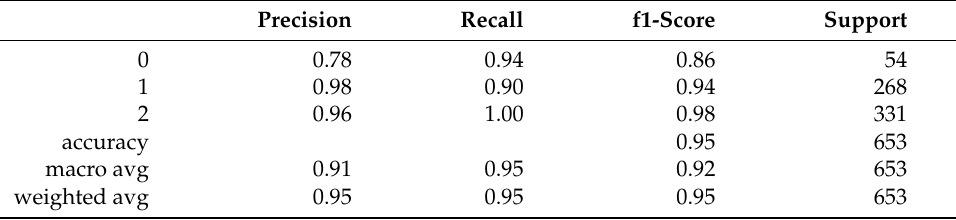
Table 16. Gradient boosting tree metrics on San Lorenzo test